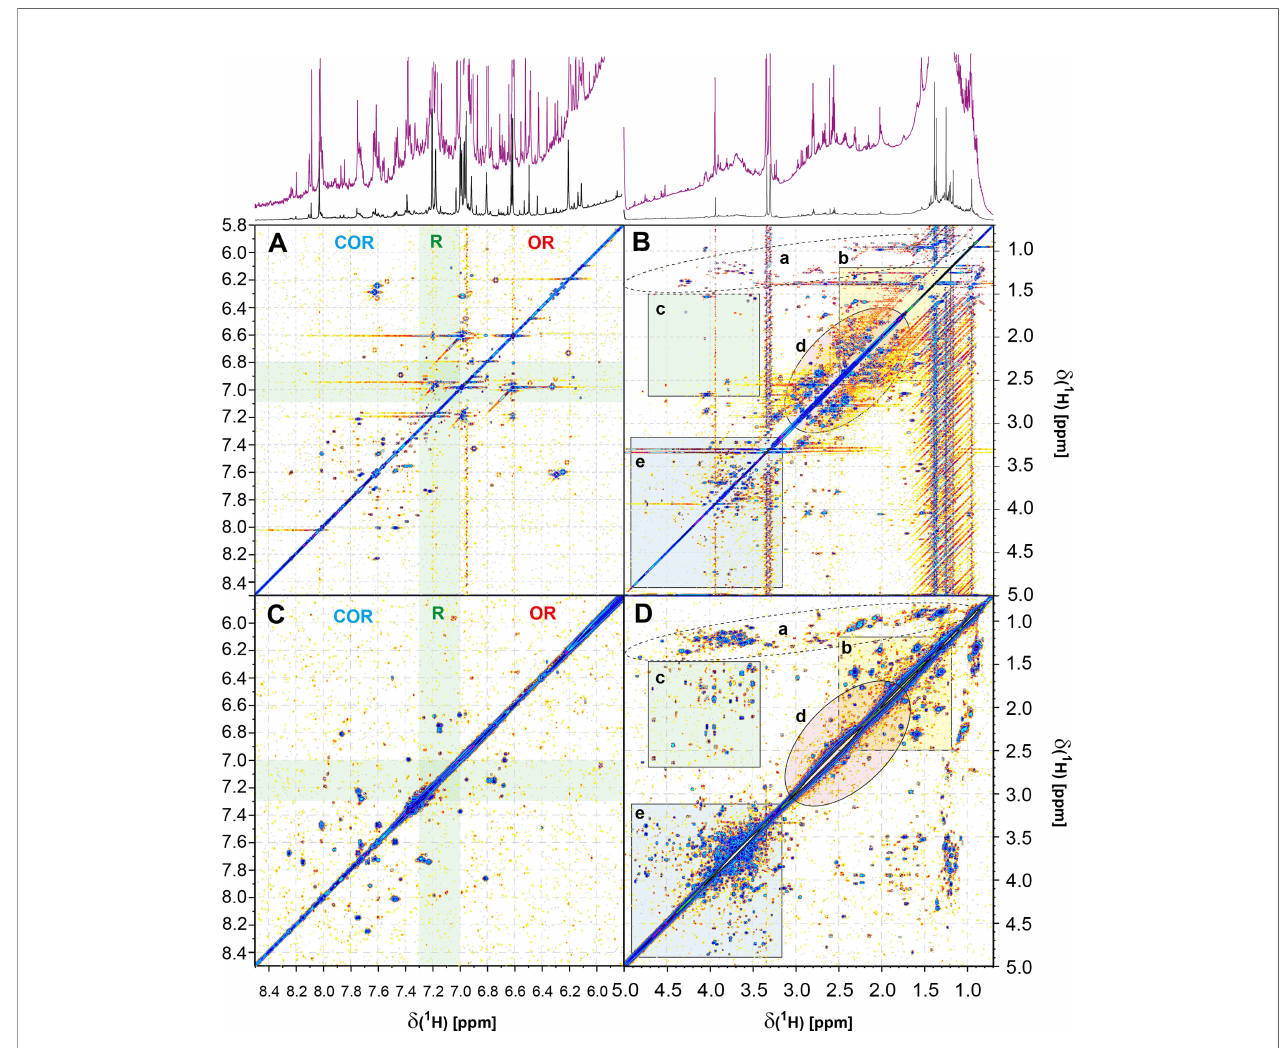
FIGURE 6 | Homonuclear two dimensional 1 H, 1 H NMR spectra and 1 H NMR projection NMR spectra above of SCS L05_1000 m SPE-DOM ( A, B , TOCSY NMR with 15 ms mixing time) and of open Atlantic Ocean fl uorescence maximum zone SPE-DOM at 48 m depth ( C, D , COSY NMR spectrum) (Hertkorn et al., 2013) demonstrate considerable biomolecular diversity of these two marine DOM. NMR spectra indicate an earlier, carbohydrate-rich stage of organic matter processing following primary production in open Atlantic Ocean surface water, compared with that of South China Sea deep water, which is further oxidized showing a high proportion of carboxyl-rich alicyclic molecules CRAM (Hertkorn et al., 2006) (cf. text; for assignment of key substructures see the supporting online